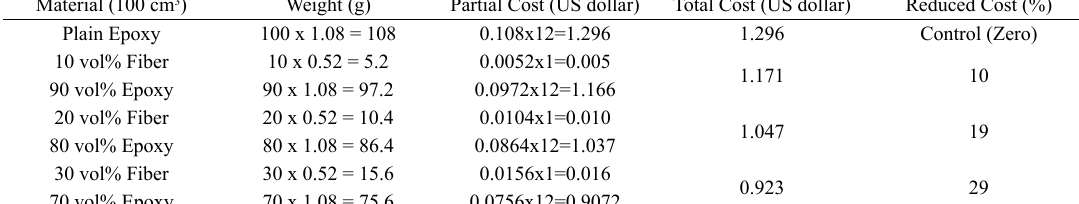
Table 3. Comparative cost-effective analyses for plain epoxy and guaruman fiber epoxy matrix composites. (Based on 100 cm 3 of material and consumer prices.) Material (100 cm 3 )